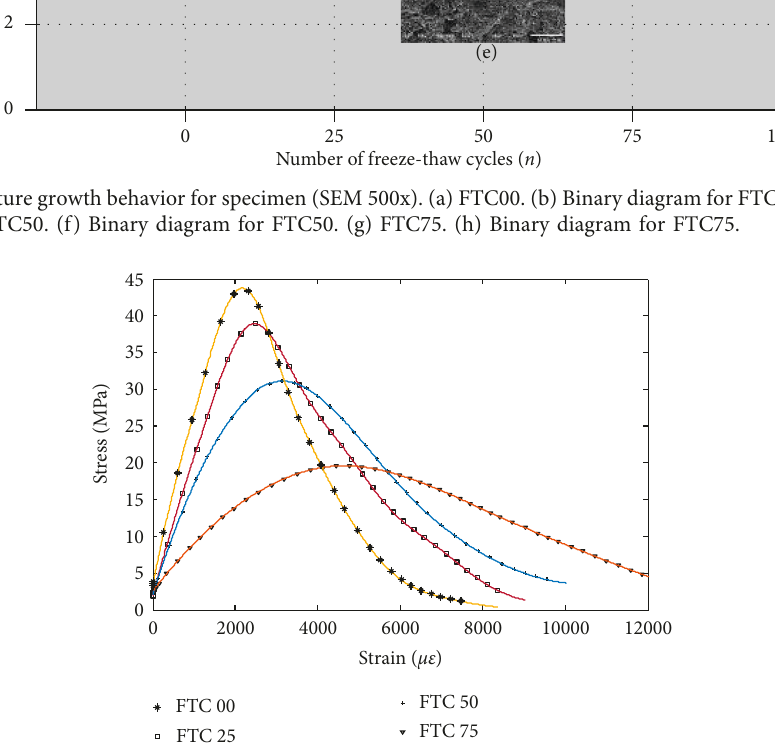
Figure 2: Full uniaxial compression stress-strain curves of concrete after different freeze-thaw cycling. Table 2: Quasi-static compression test results of concrete after different numbers of freezing-thaw cycles. Number of freeze-thaw cycles Note . f cm is the peak stress and ε cm is the strain at peak